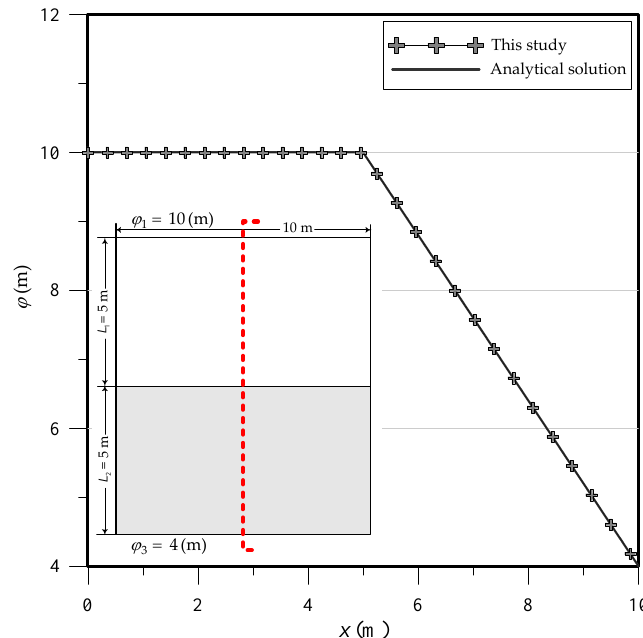
Figure 10. The computed head and the analytical solution in two-layered soils.